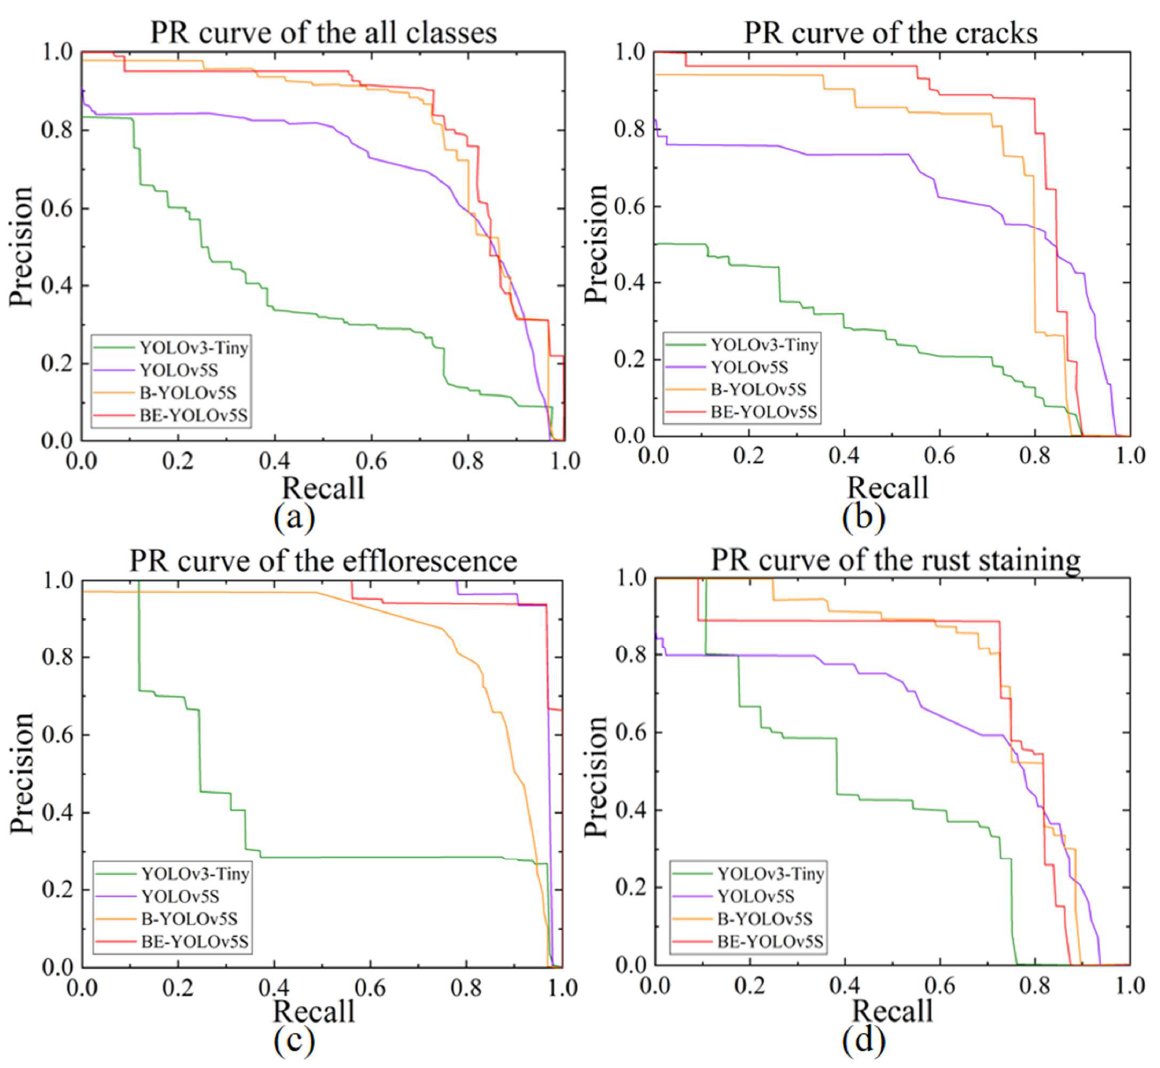
Figure 8. The PR curve plot of the relevant experimental models in this paper was tested in the BDD test set. ( a ) PR curve of all classes, ( b ) PR curve of the cracks ( c ) PR curve of the efflorescence, and ( d ) PR curve of the rust staining.